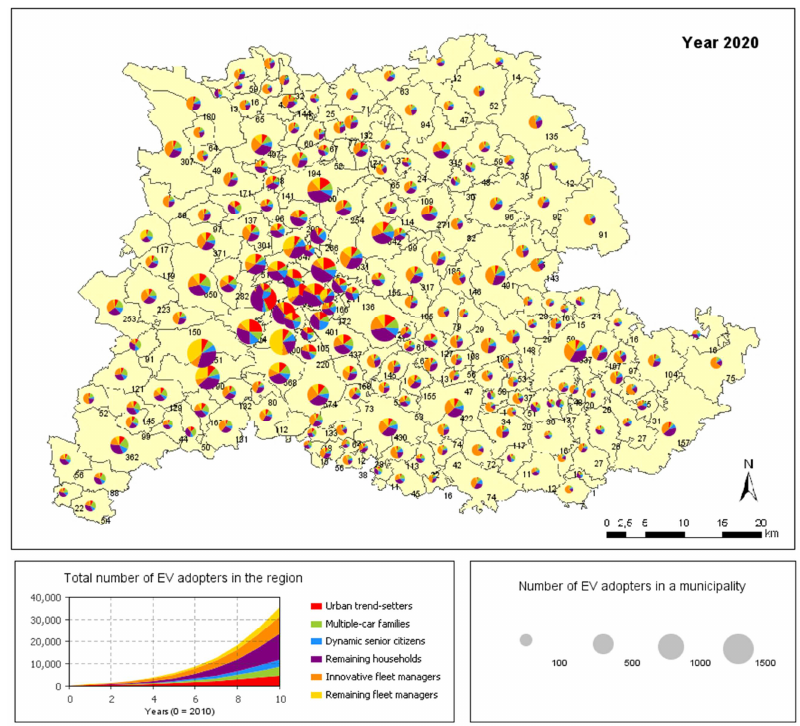
Figure 2. Basis scenario of the development of EV ownership in the municipalities of the Region